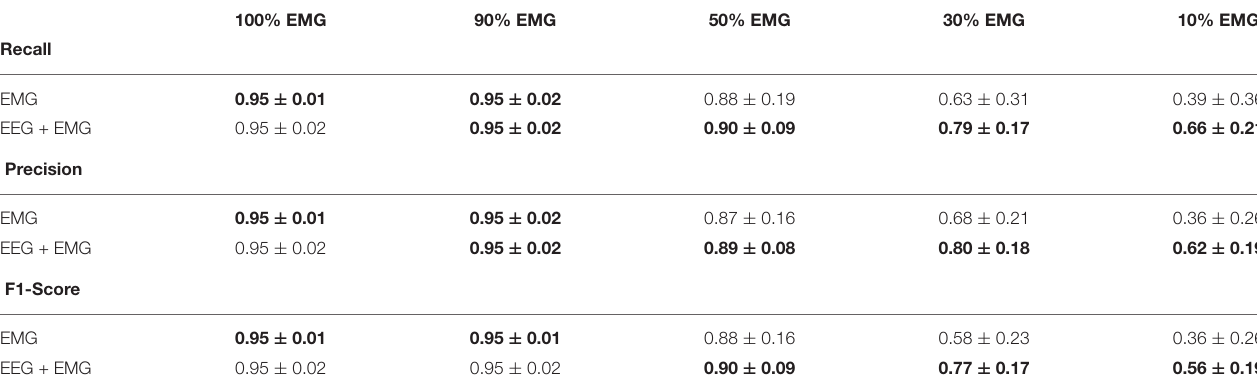
TABLE 1 | Classification performance averaged across subjects in five different conditions (100, 90, 50, 30, and 10% of EMG signal amplitude) using only the EMG signals or by the use of EEG and EMG signals together.